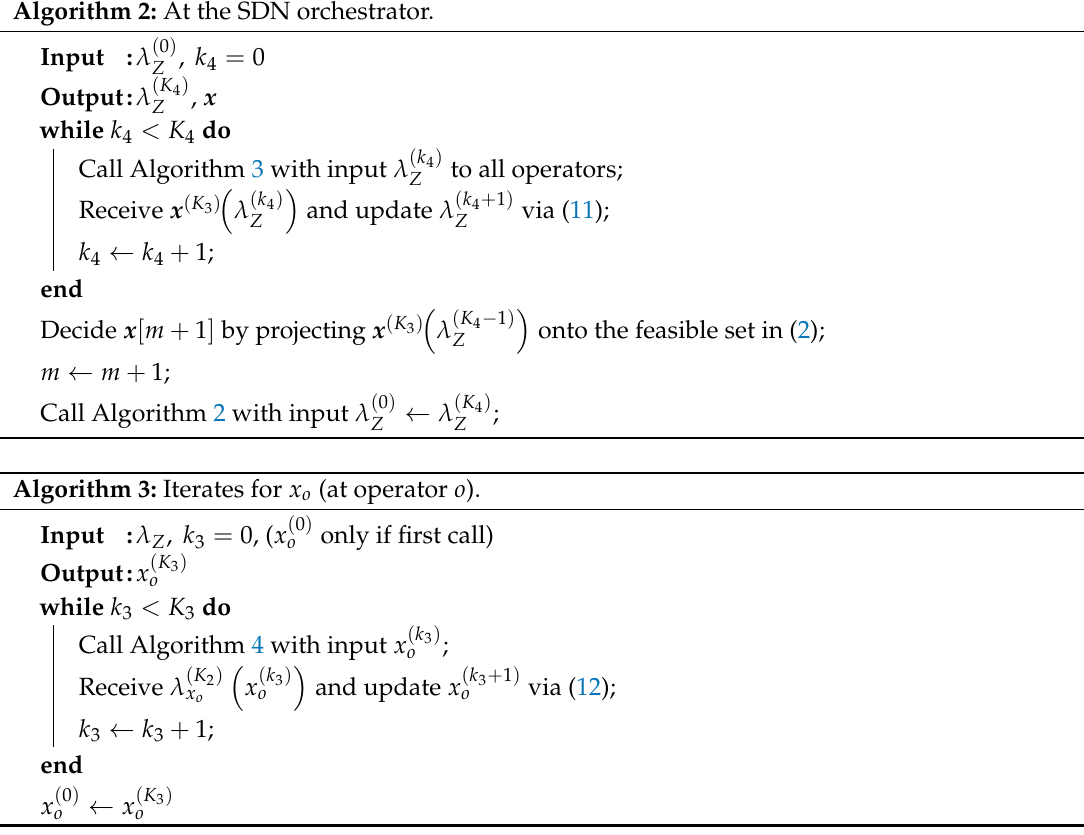
Fig. 3: Aggregate rate allocation for the two operators for different values of V and when no sharing across operators is enabled